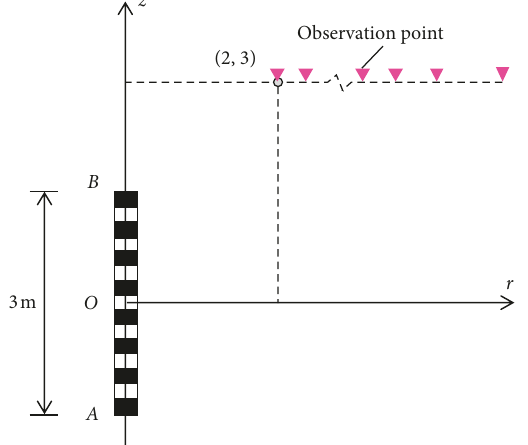
Figure 12: Illustration of the observation points along the radial direction of the cylindrical